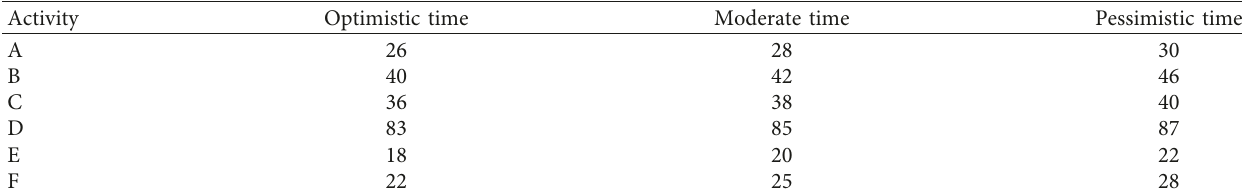
Table 6: Activity duration.